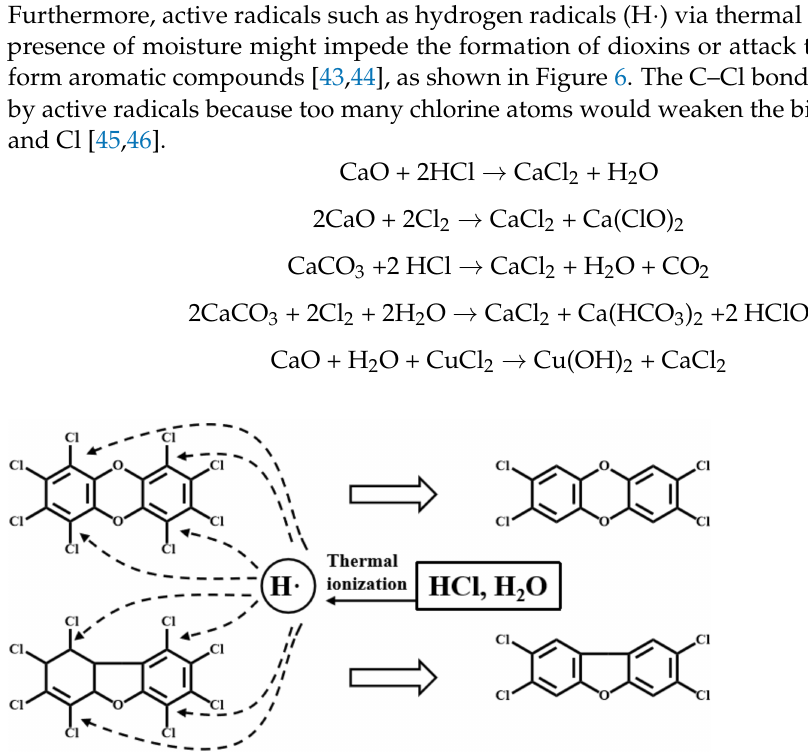
Figure 6. Schematic diagram of the hydrogen radical (H) attacked C–Cl bond on PCDD/Fs